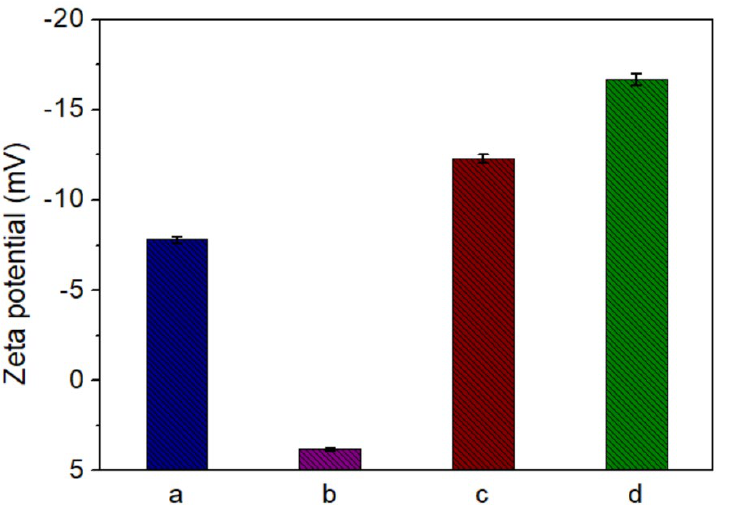
Figure 2 . Zeta potential profiles for (a) magnetic beads, (b) aminated MMSNs, (c) cDNA-MMSNs and (d) and (d) aptamer/cDNA-MMSNs.